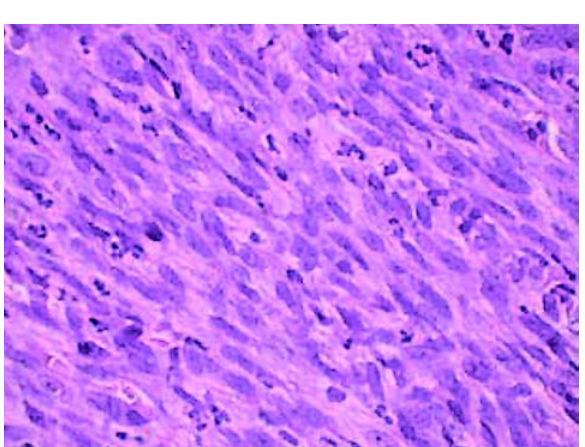
Figure 1 – Bundles of spindle-shaped cells with elongated and occasional pleomorphic nuclei (X400).